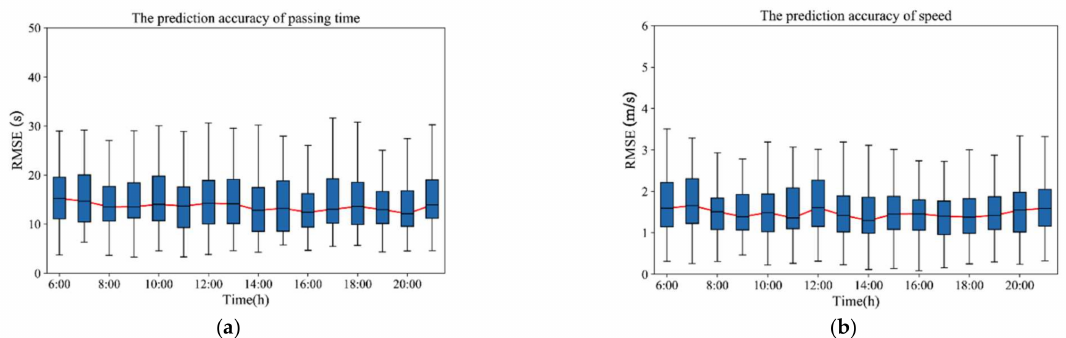
Figure 17. The prediction accuracy in different time of day: ( a ) The prediction accuracy of the passing time; ( b ) The prediction accuracy of speed.